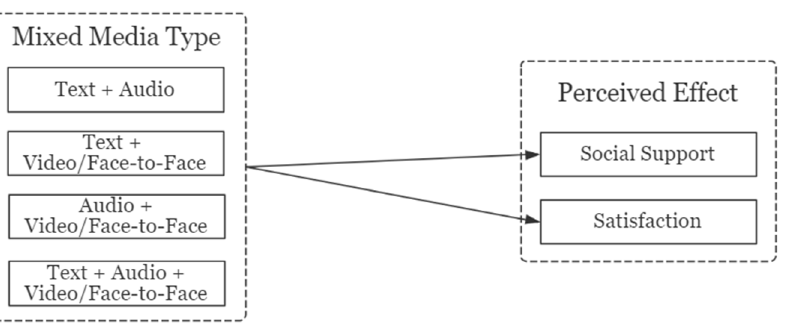
Figure 1. Research model 1. Table 2. Tests of normality—perceived social support in mixed media.